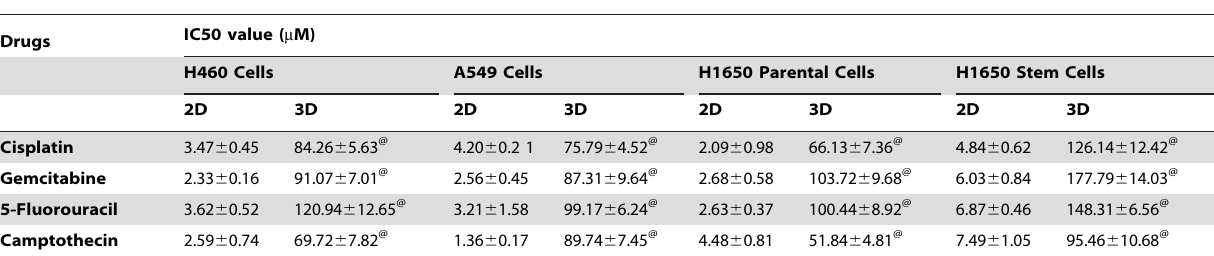
Table 2. Comparative analysis of IC 50 values of various anticancer drugs in 2D and 3D systems.